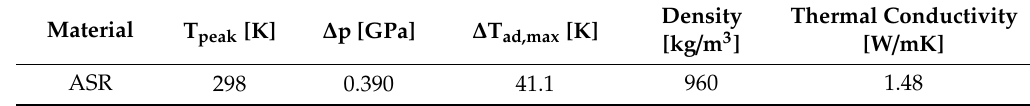
Figure 2. Adiabatic temperature change as a function of the working temperature of acetoxy silicone rubber for decompression (∆p = 0.390 GPa). Table 1. Thermal and physic features of acetoxy silicone